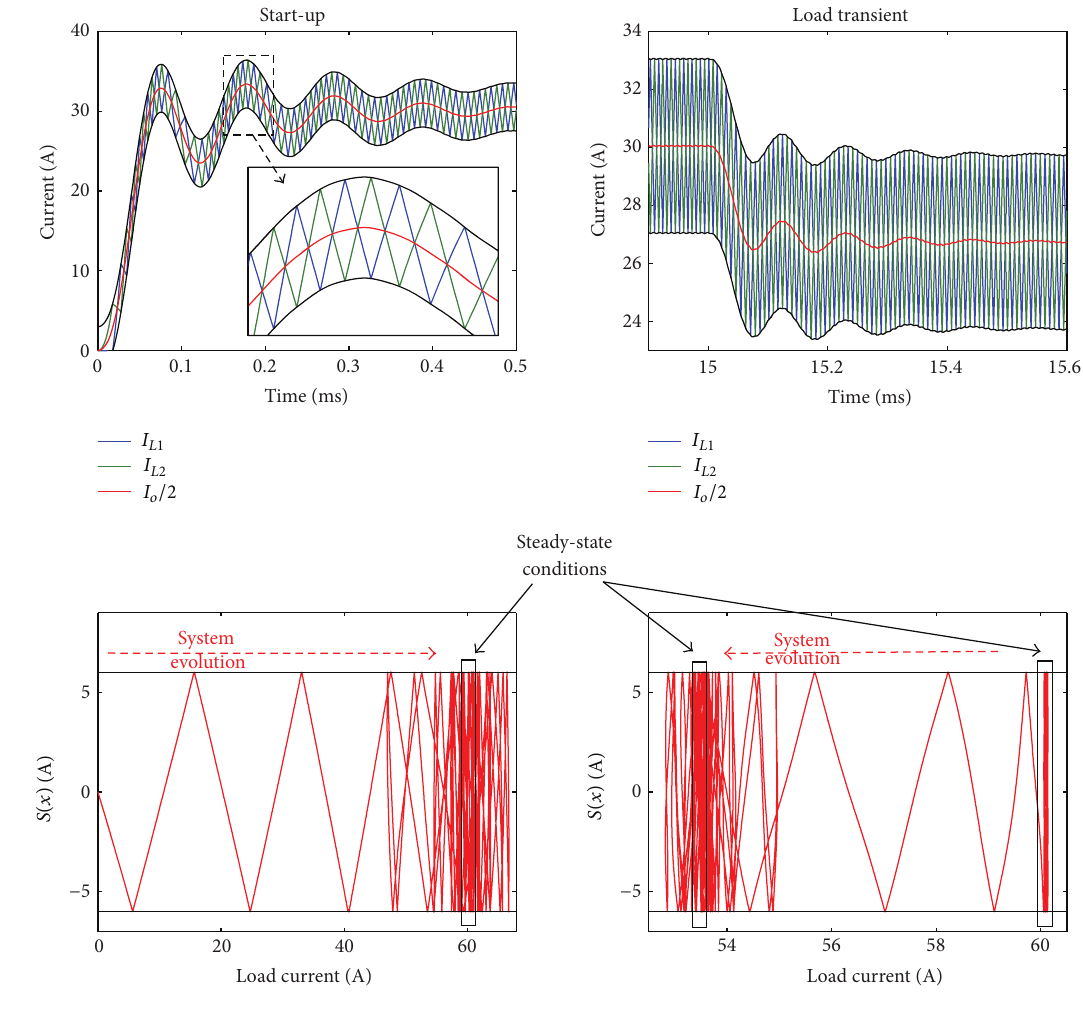
Figure 9: Postfilter simulation: start-up and load transient